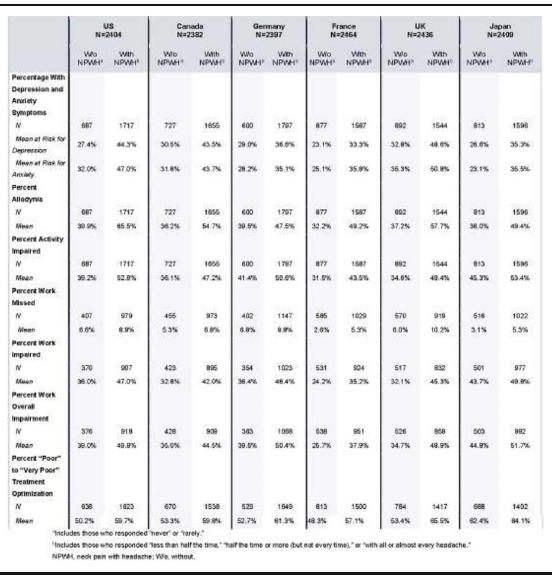
Table 1 (abstract P243). Frequency of Depression, Anxiety, Allodynia, Impairment in Daily Activity, Work Time Missed, and “ Poor or Very Poor ” Treatment Optimization Among Migraine Respondents With and Without Neck